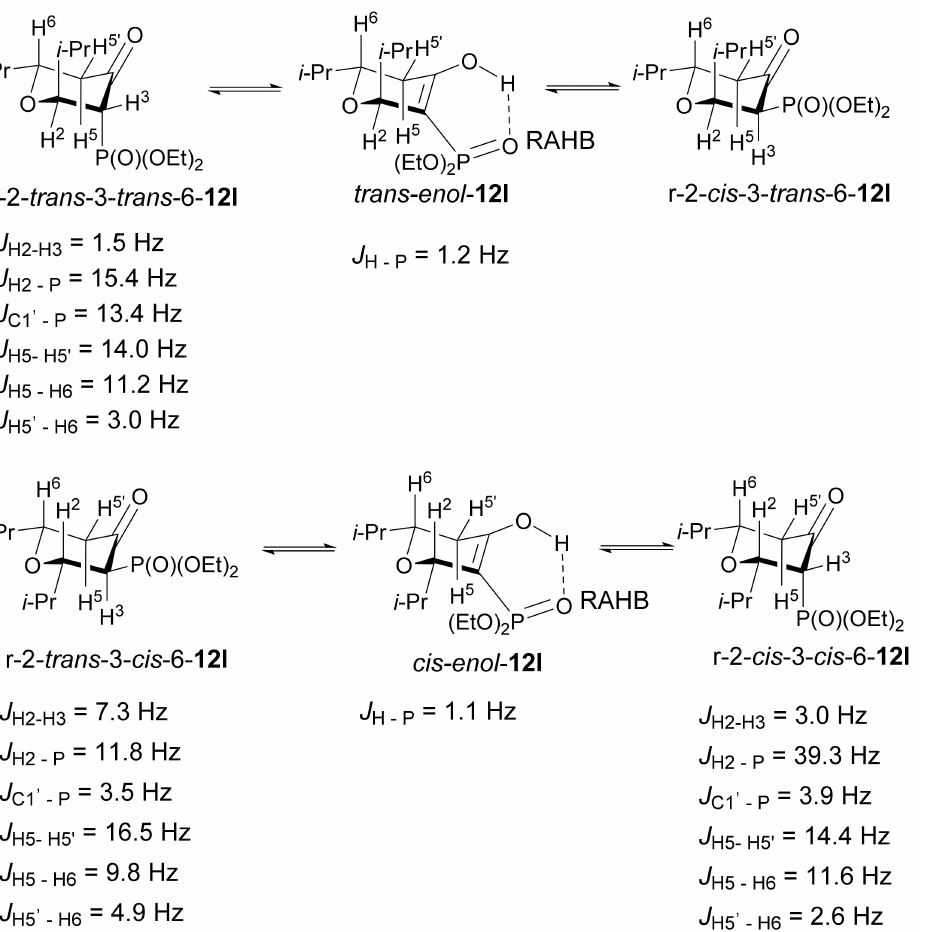
Figure 3. Characteristic coupling constants of the isomers of 3-diethoxyphosphoryl-2,6- diisopropylpyran-4-one 12l .